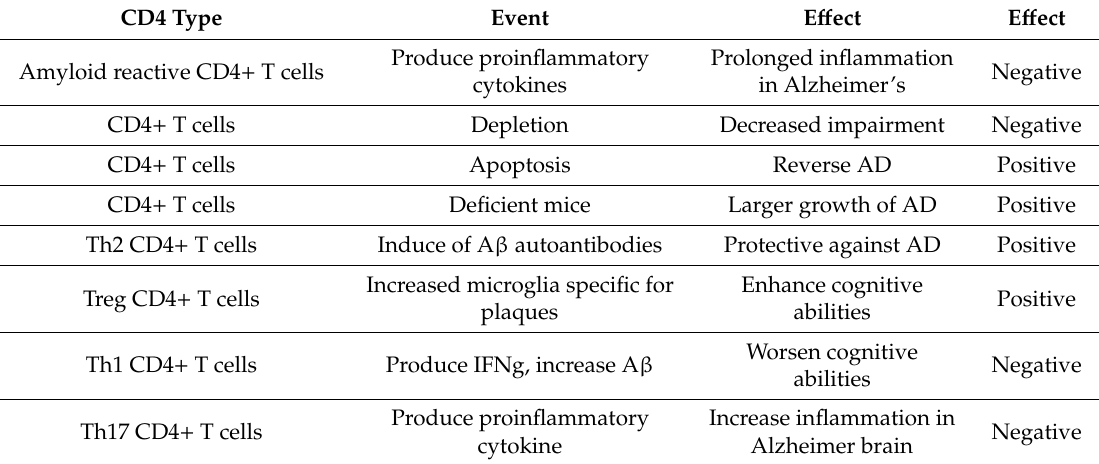
Table 1. Role of CD4 + T cells in